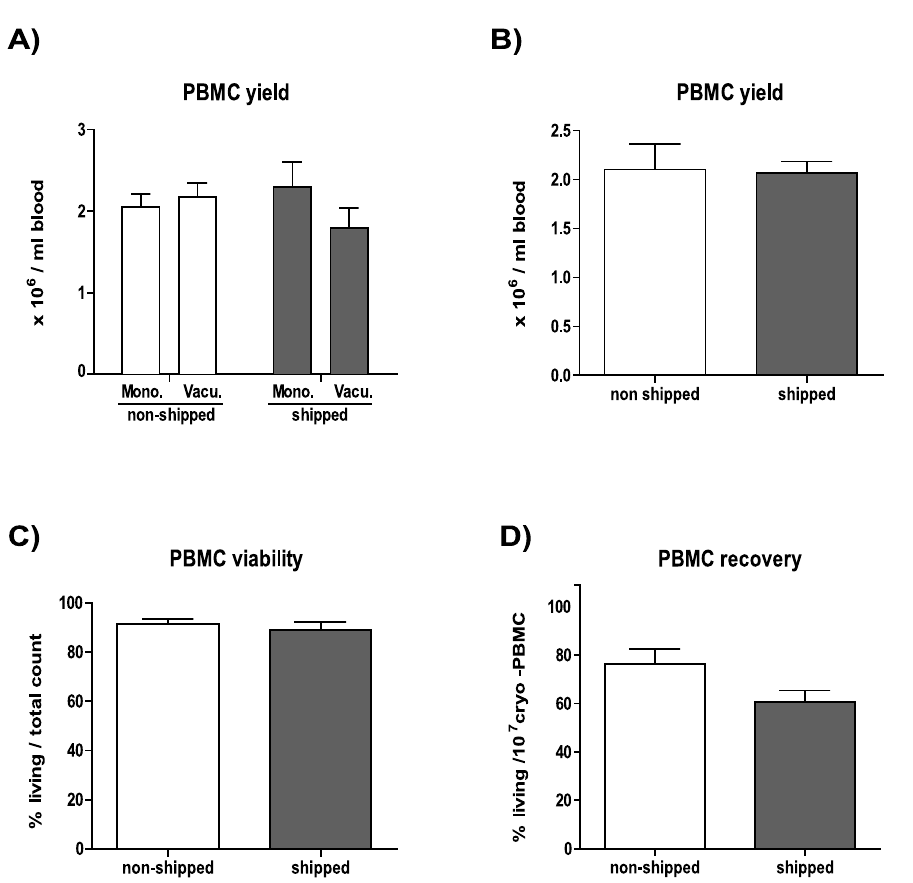
Fig. 1. The effects of overnight shipping on PBMC yield and survival. The cell number of blood derived PBMC was determined based on Trypan blue exclusion. A) Blood was collected in S-Monovette (Sarsted) or K2E Vacutainer (BD) tubes from 4 donors on site or at another location. Shipped samples were transported in the collection tube. PBMC yield was calculated per volume (10 6 living PBMC/ml blood). B) Yield (10 6 living PBMC/ml blood) is shown for PBMC derived from non-shipped vs. shipped blood (n 5 9) prior to freezing. C) Viability (% of living cells/total cell count) is shown for non-shipped vs. shipped samples (n 5 9), prior to freezing. D) Post-cryopreservation recovery is calculated for thawed samples (non-shipped vs. shipped, n 5 9) and is provided as percentage of living cells from 10 7 total (frozen